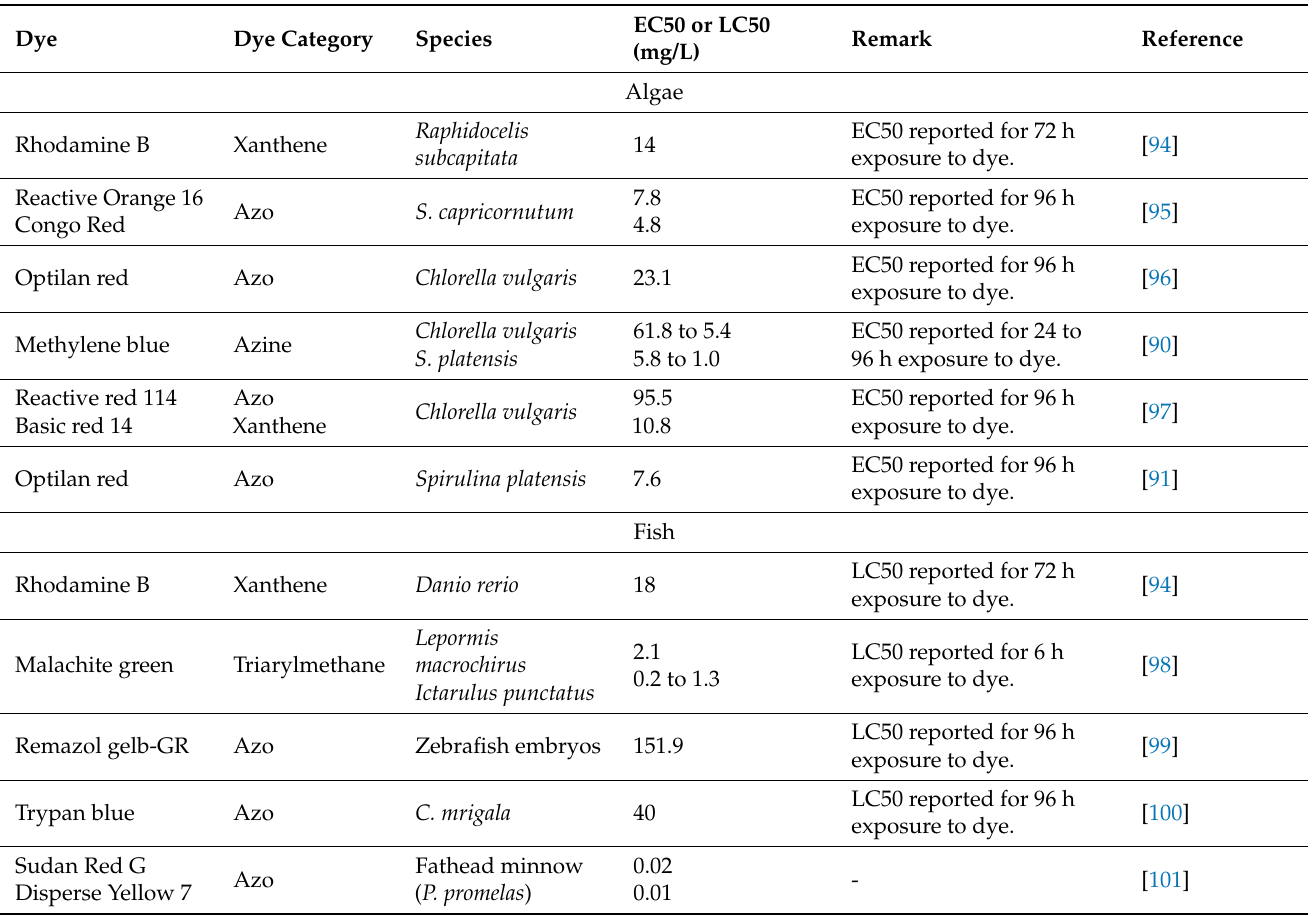
Table 2. Toxicity of different dyes on fish and